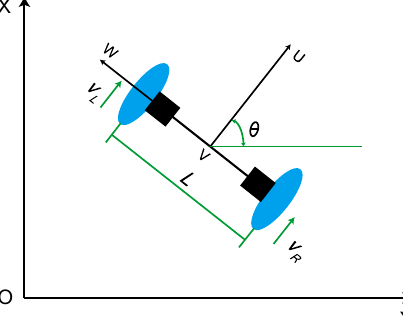
Figure 3. Kinematic model of cleaning robots.